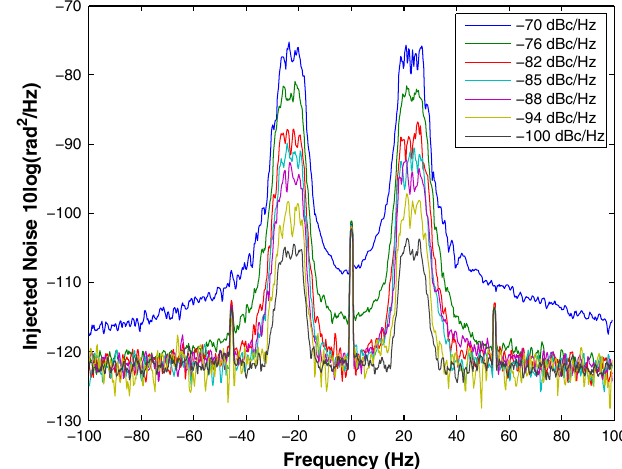
FIG. 9. Levels of injected noise around f axis shifted by f